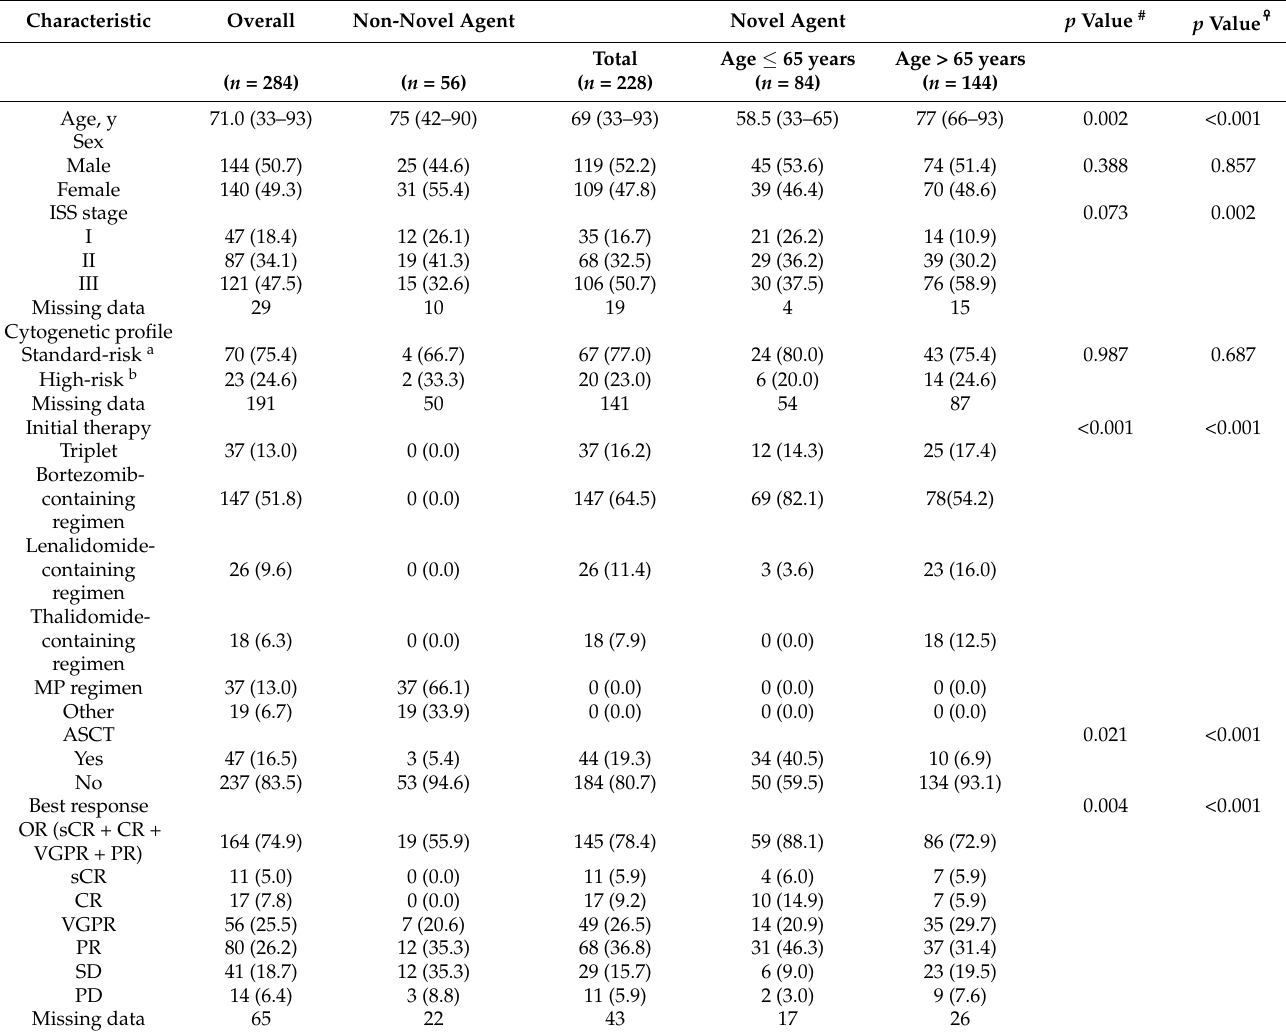
Table 1. Patient characteristics and clinical summary.